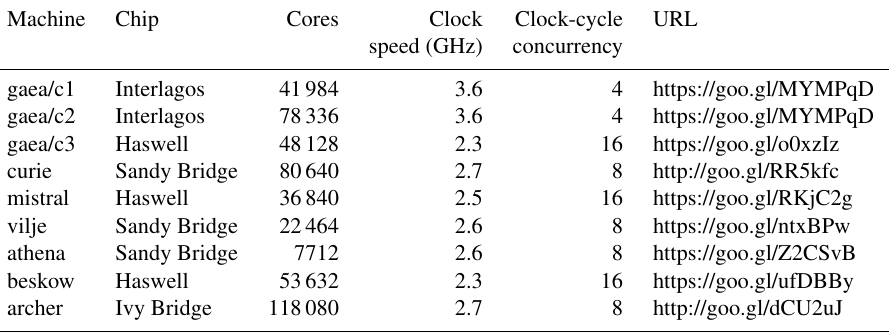
Table 4. Details of platforms used in this study. The product of cores, clock speed, and clock-cycle concurrency should yield theoretical peak speed, but as we see in the results of, and discussion around, Tables 1 and 3, the actual performance is rather different. Machine Chip